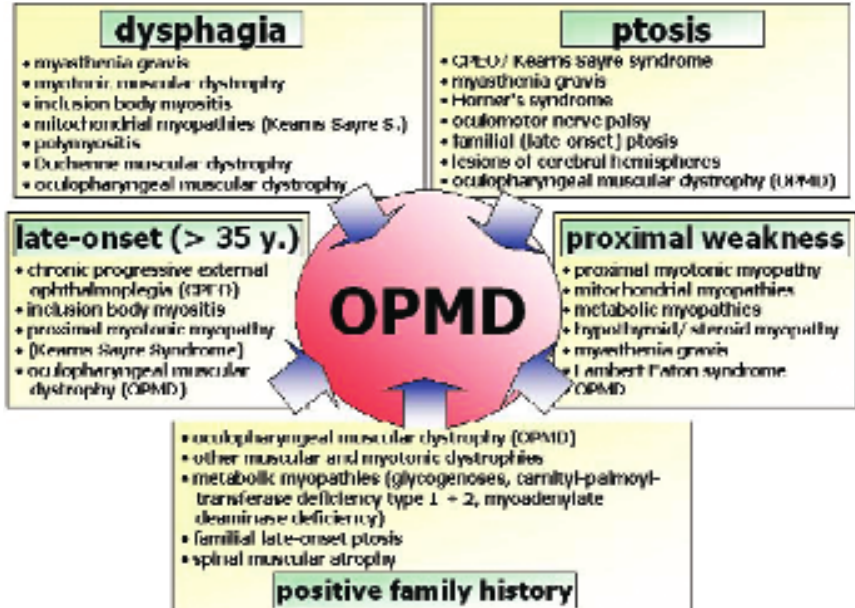
Figure 3 Differential diagnosis of OPMD dependent on its key features (dysphagia, ptosis, proximal weakness, late-onset (>35 y.), and positive familial